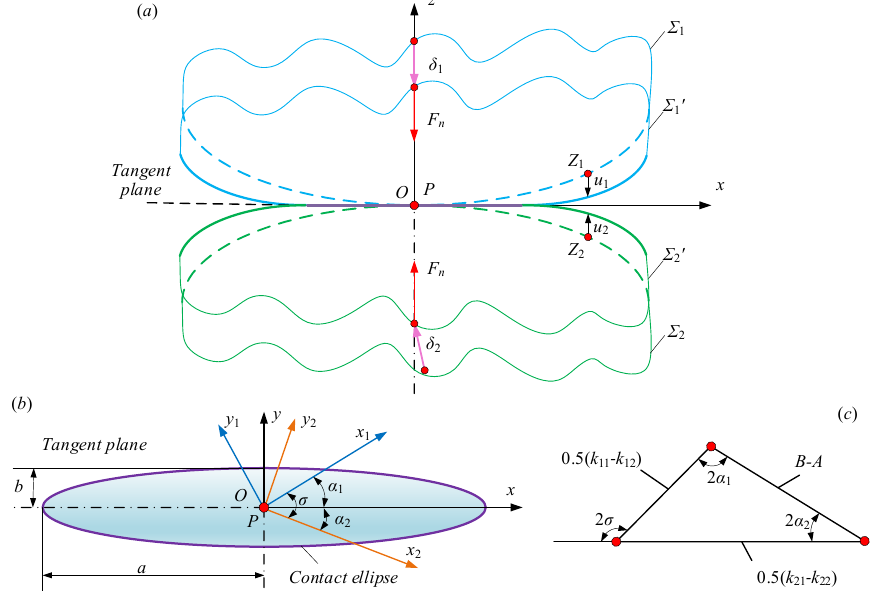
Figure 4. The elastic deformation of the contact point: ( a ) deformation diagram; ( b ) contact ellipse; ( c ) curvature relationship.